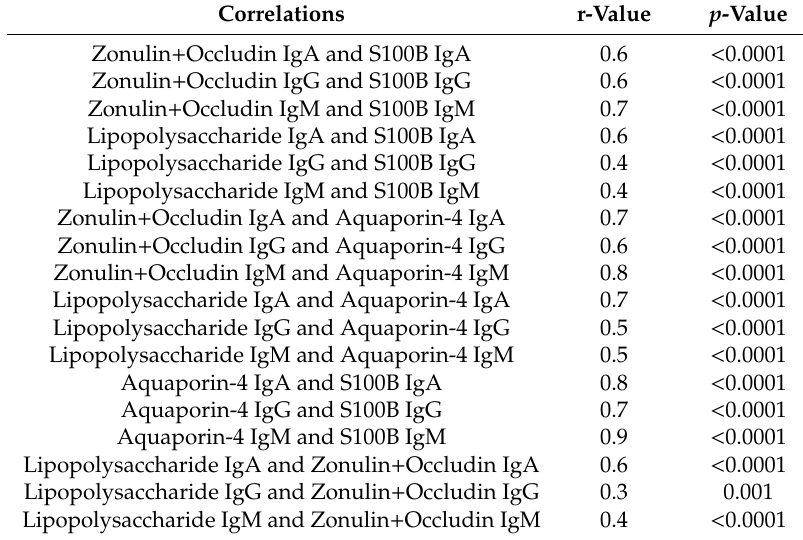
Table 5. Correlation coe ffi cients and p -values for barrier protein antibodies for anti-neutrophil cytoplasmic antibodies (ANCA) positive